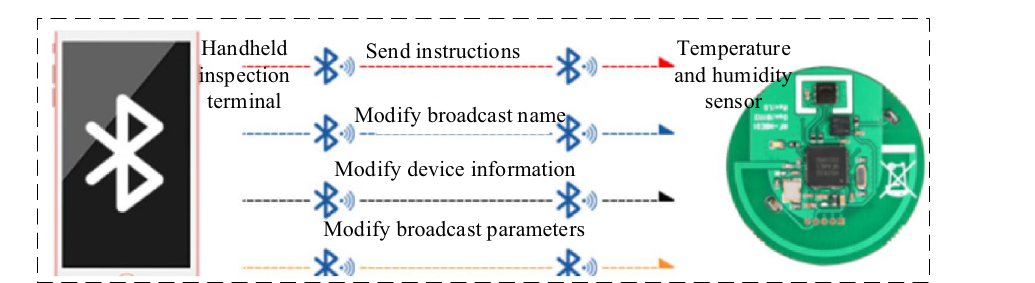
Figure 3. Schematic diagram of temperature and humidity sensor principle.